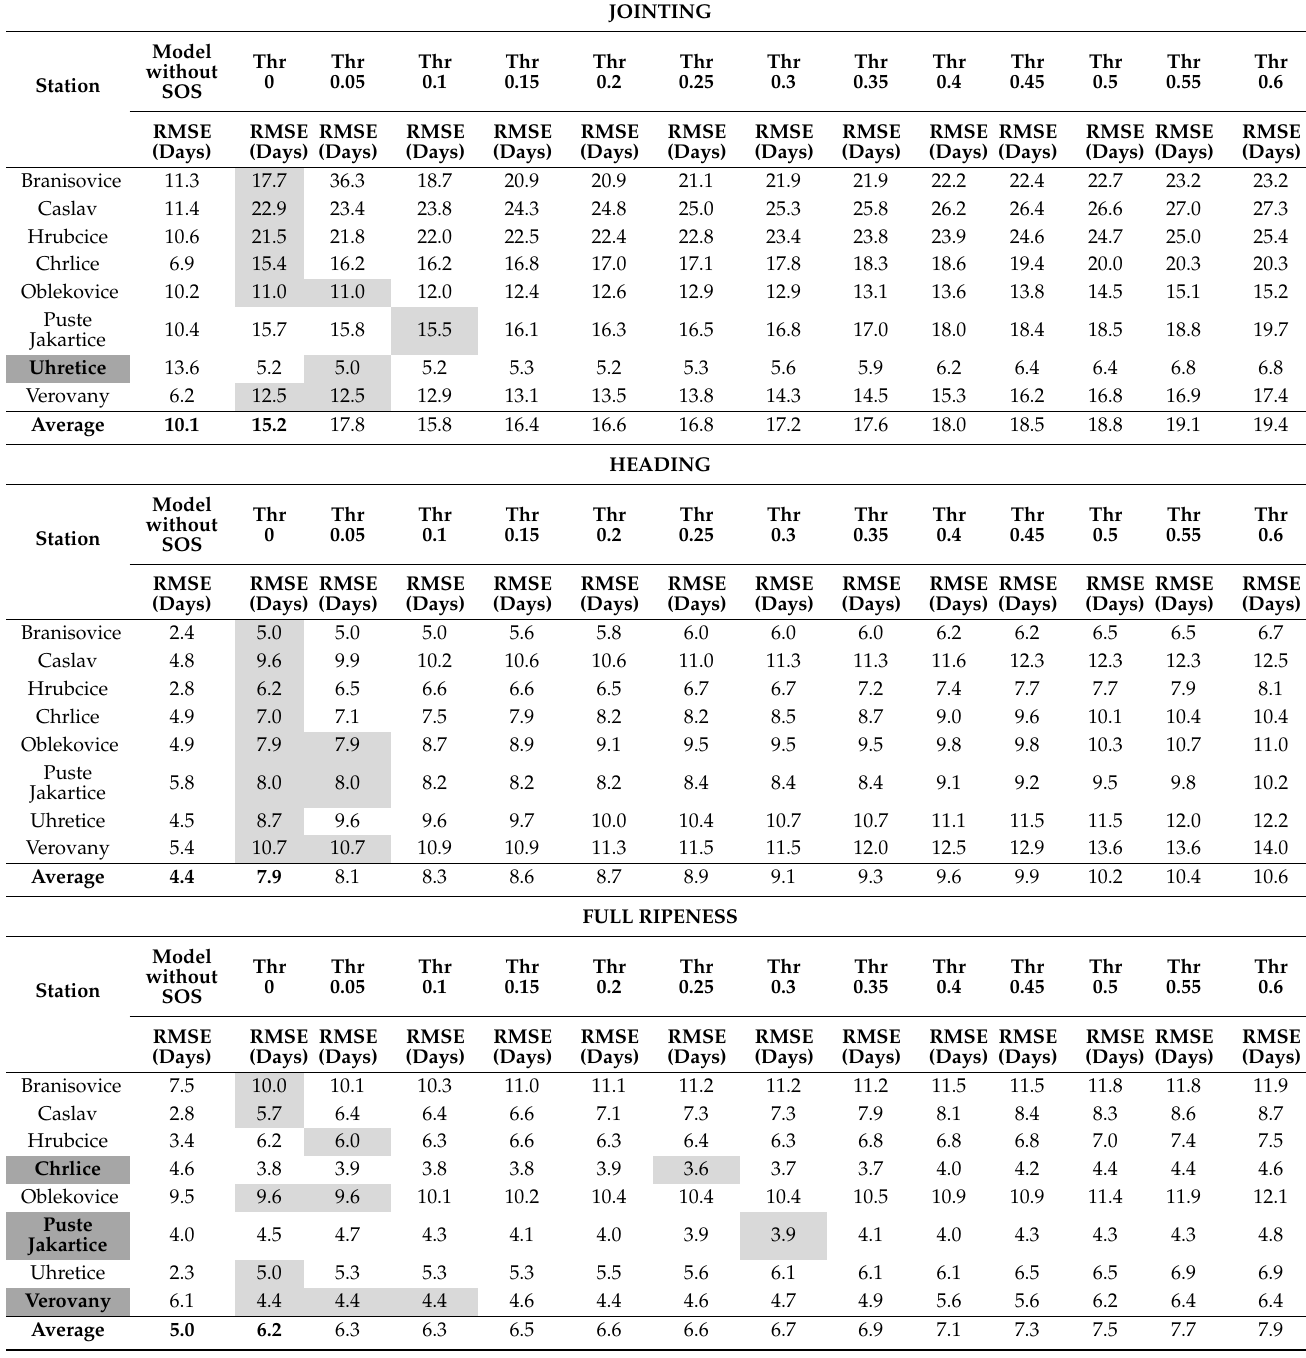
Table A3. The RMSE values describe the accuracy modeled at the onset of the jointing, heading, and full ripeness phenophases. Thr-0 to Thr-0.6 indicate the RMSE values for modeled onsets of phenophases, including the start of the growing season derived from EVI2. The lowest values for each station are highlighted with a light gray background. A dark gray background highlights the station; the model including SOS is better than the model without